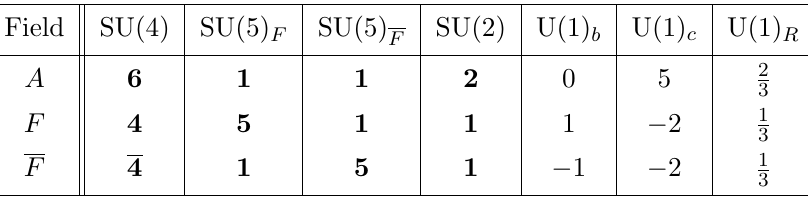
Table 1 . The (cid:12)elds appearing in the proposed dual of the rank 1 E 6 theory, shown with their charges under the gauge and global